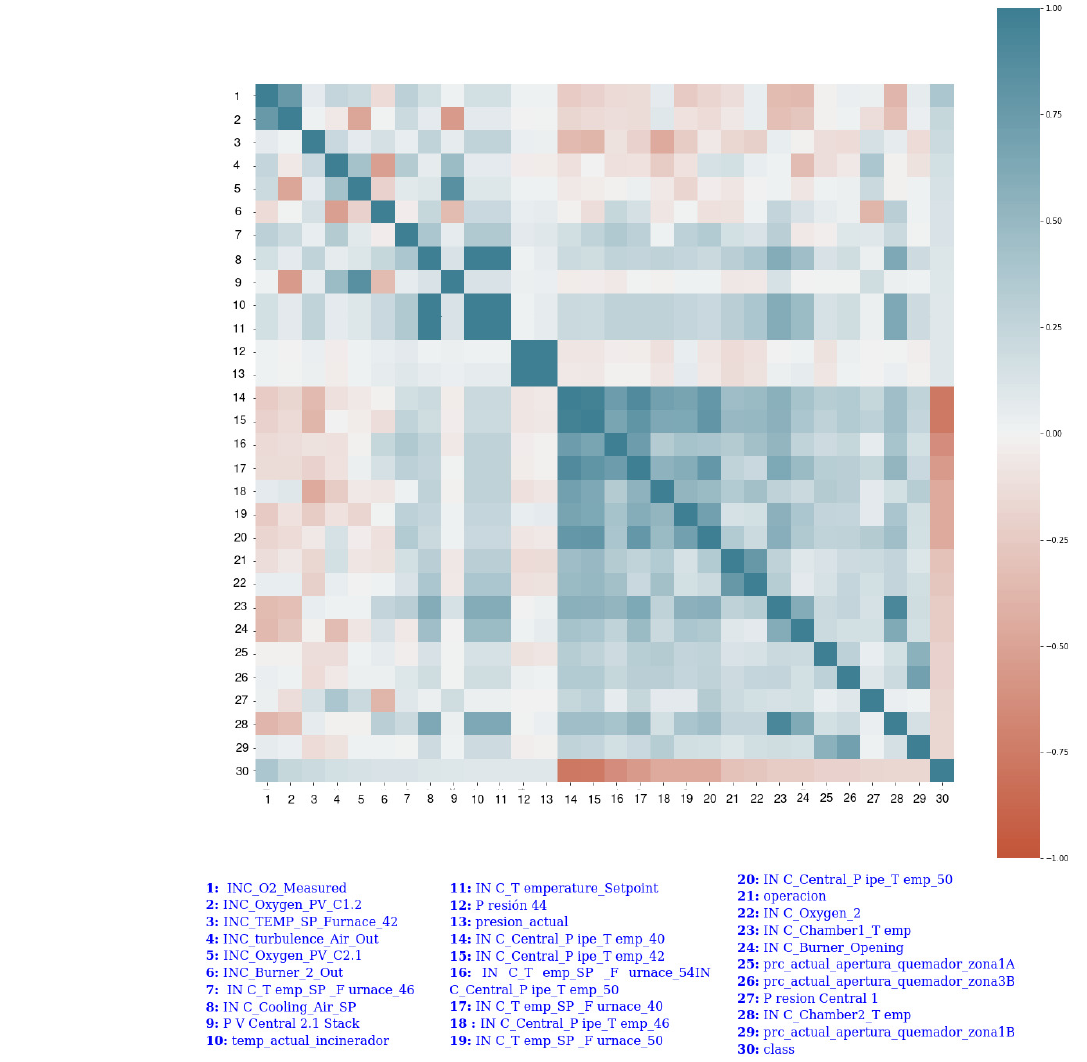
Figure A1. Heat map of the more correlated variables with the target